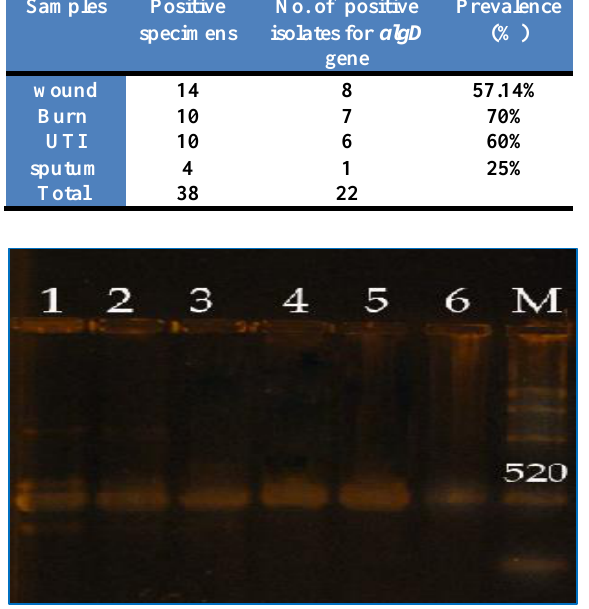
Figure, 1: Agarose gel electrophoresis of PCR products for alg D gene. Lanes M: marker ladder 100-bp. Lanes 1, 2, 3, 4, 5 and 6: alg D gene with 520 bp. Lane 9: negative control.